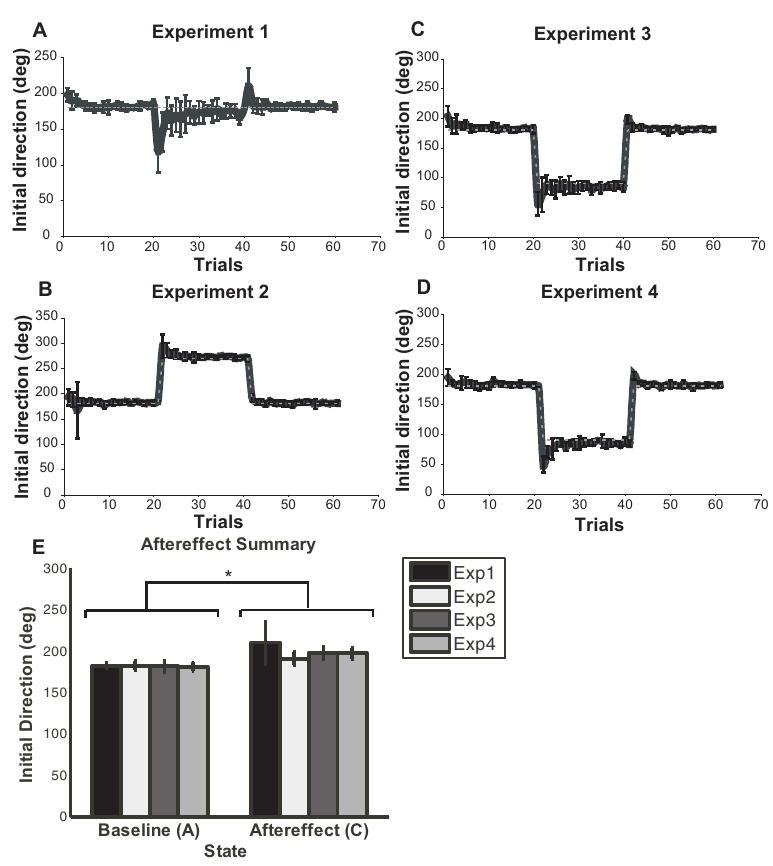
Figure 7. Experimental results for the 90° experiment. The figure shows initial direction measurement of the movement observed on screen. This is the trial by trial average of all eight subjects. The error bars mark the standard deviation amongst the subjects and the dotted grey line represents the desired target angle observed on screen. The vertical axis is the initial direction measured in degrees and the horizontal axis is the trial number. A . Experiment 1, same task different environment. B . Experiment 2, different task same environment. C . Experiment 3, different task different environment. D . Experiment 4, different task different environment (same display target). E . Group mean of the last trial in state A (baseline) compared to the first trial in state C (aftereffects) in a bar graph. Asterisks indicate statistical significant difference between groups (p <